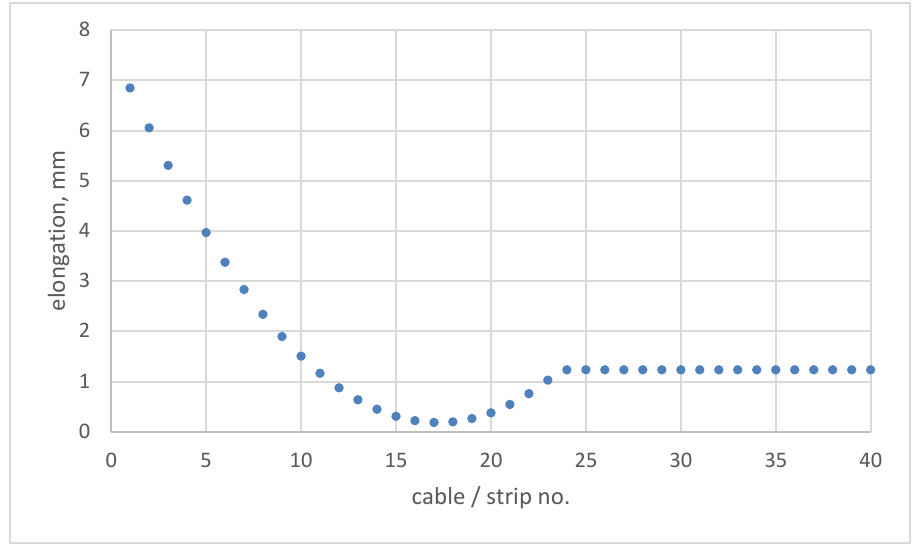
Figure 4. Cable/strip elongation in the transition section of the belt conveyor identified from the geometrical model ( L e = 2.6 m, B = 1.2 m, e = 80 mm, α = 45°).